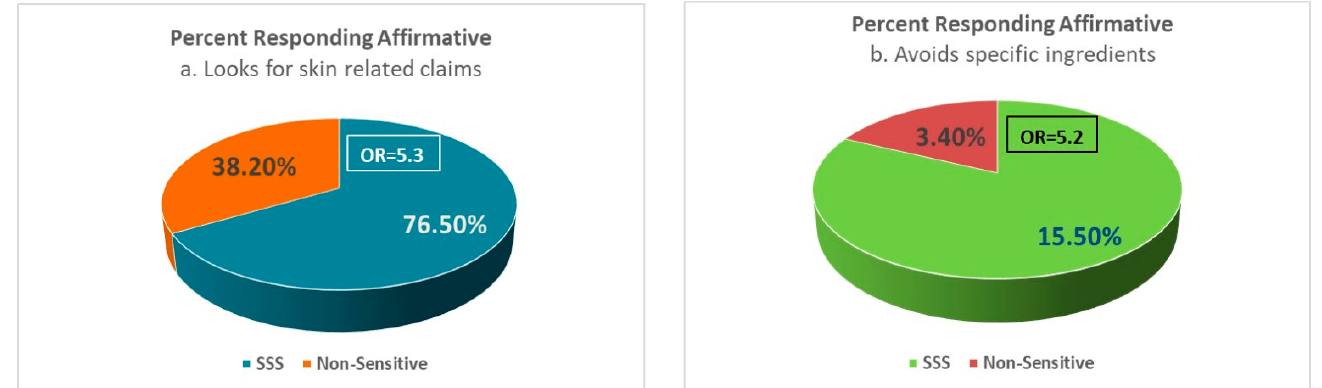
Figure 4. SSS Consumers and Shopping Practices. In the Cincinnati study, responders were asked about specific shopping practices. Compared to the non-SS group, the SS subjects were far more likely to: ( a ) look for skin related claims on products (such as, “safe for sensitive skin” and “hypoallergenic”) (OR = 5.3), and ( b ) avoid specific ingredients when shopping (OR = 5.2).